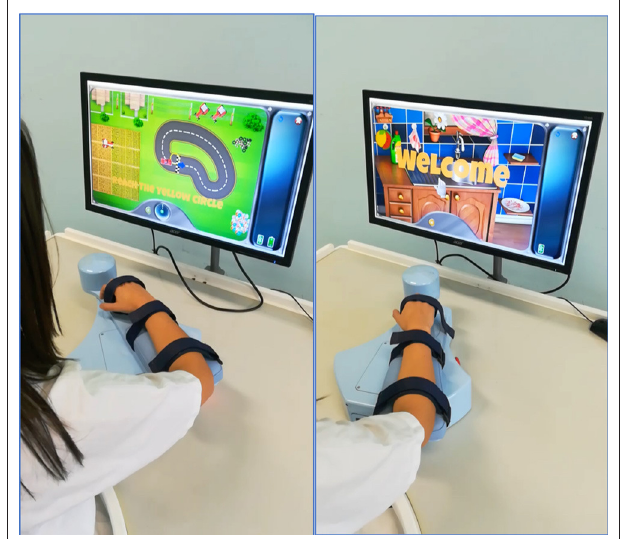
FIGURE 1 | The upper limb robot-assisted training